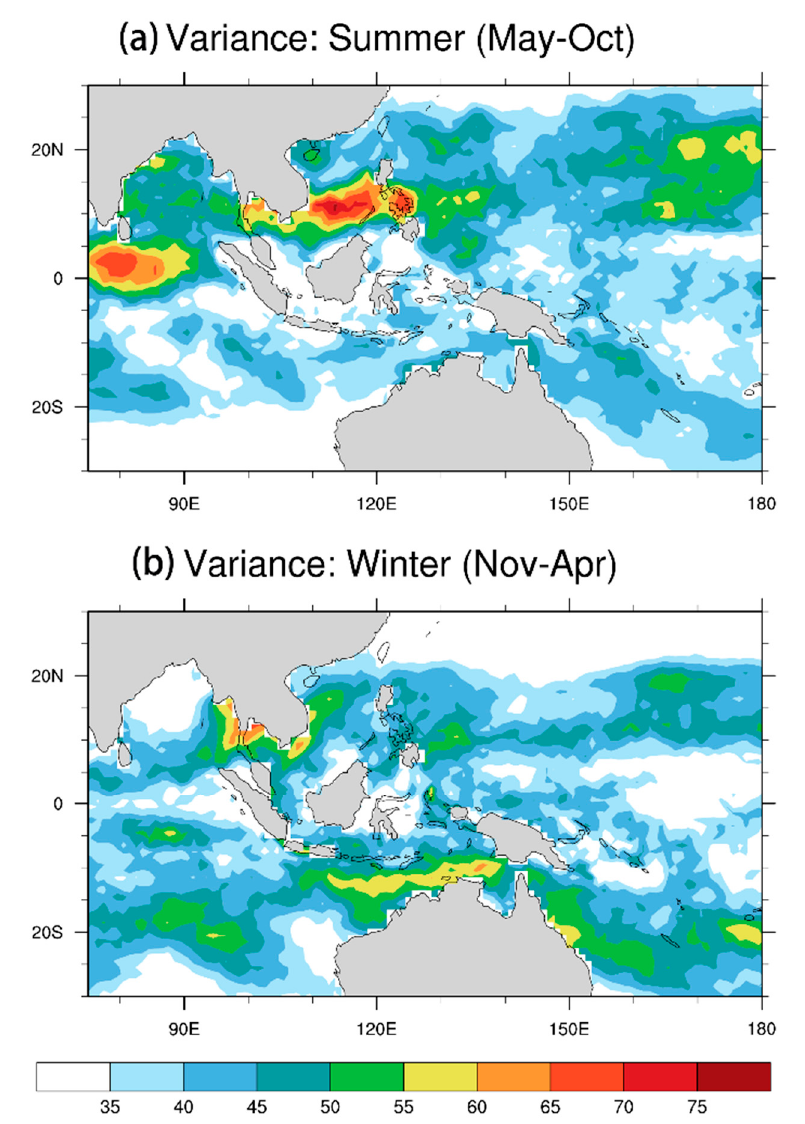
Figure 3. Variance of the boreal summer intraseasonal oscillation (BSISO)-related lower tropospheric